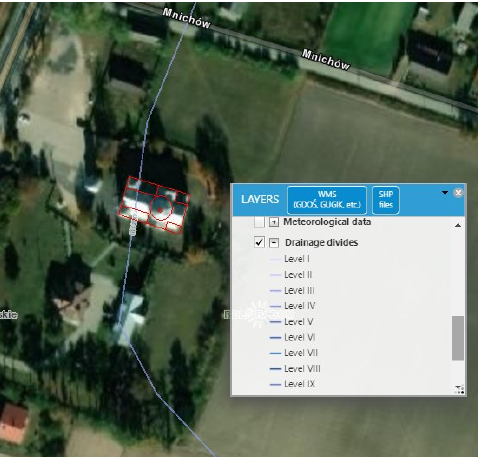
Figure 13. View of identified displacements of church structure.